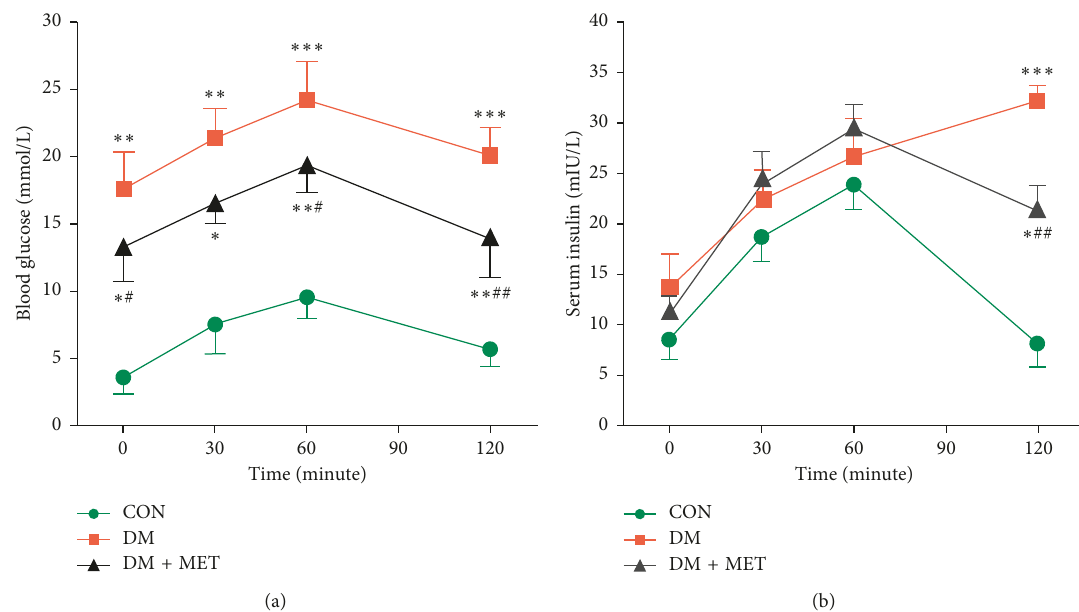
Figure 2: Effects of metformin on HFD/STZ-induced type 2 diabetic rats. Diabetes was induced in Wistar rats and then administered with or without metformin. At the end of the experiment, rats were fasted for 16hours. OGTT was performed, and blood glucose (a) and serum insulin (b) at 0, 30, 60, 90, and 120 minutes were recorded. Data are mean ± SEM. ∗ Mean is significantly different compared with that of the CON group. # Mean is significantly different compared with that of the DM group ( ∗ p < 0 . 05; ∗∗ p < 0 . 01; ∗∗∗ p < 0 . 001; # p < 0 . 05; ## p < 0 . 01). Table 2: Biochemical characteristics after administration of metformin.